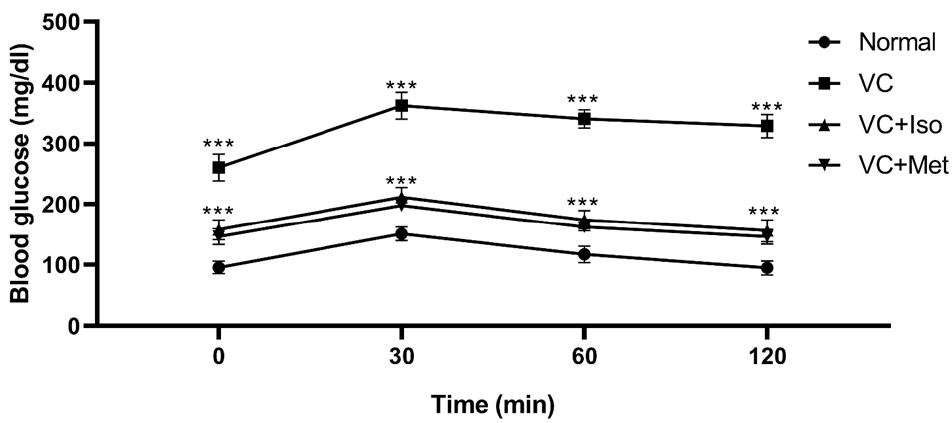
Figure 2. Isorhamnetin reduced glucose level during intraperitoneal glucose tolerance test (IPGTT). Isorhamnetin significantly reduced glucose in diabetic mice during intraperitoneal glucose tolerance test. Mice were fed with HFD for 8 weeks followed by two low doses of STZ injection (40 mg/kg), after diabetes confirmed, mice were treated with 10 mg/kg isorhamnetin or 200 mg/kg metformin for 10 days, mice were then fasted overnight before injection with 0.5 g/kg glucose intraperitoneally, and glucose level determined at 0, 30, 60, and 120 min. Two-way ANOVA followed by Tukey post hoc, *** p < 0.001. VC; vehicle control, Iso; isorhamnetin, Met; metformin.